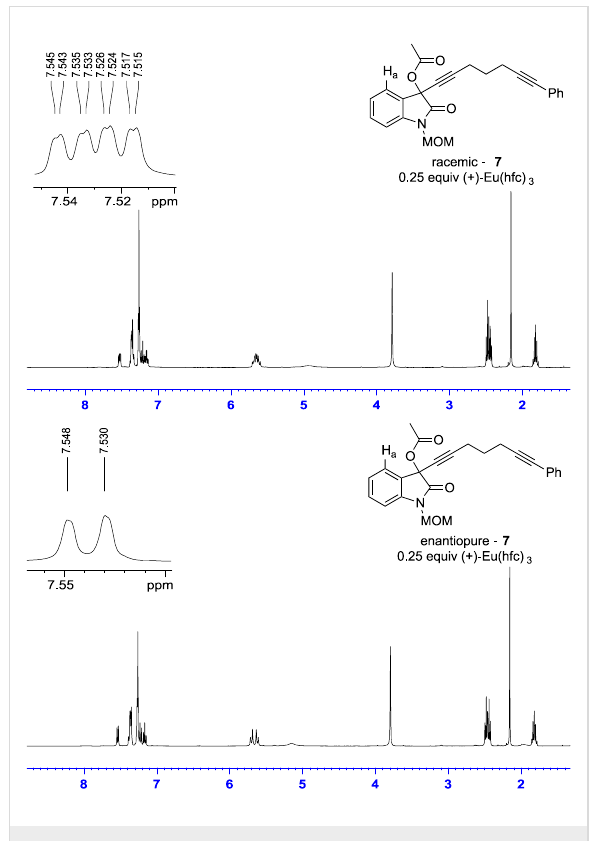
Figure 1: Chiral NMR shift analysis of propargyl acetate 7